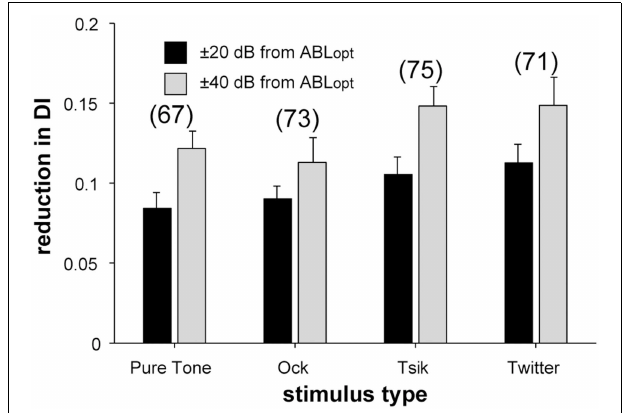
FIGURE 9 | Reduction in DI upon presentation of non-ABL opt sound levels. The difference in DI in response to ABL opt and non-ABL opt is illustrated for each of the four stimuli separately; bars indicate means and error bars are SEM. Color code as per the legend indicates the absolute difference of ABL from ABL opt . Numbers in brackets the number of cells included for each